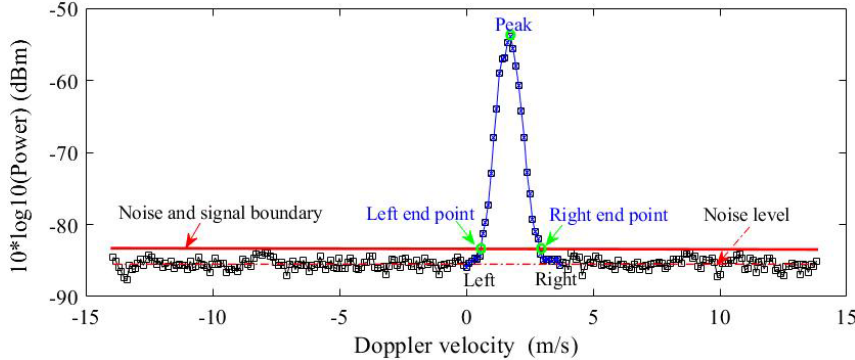
Figure 5. Schematic diagram of cloud signal recognition in Doppler spectra.